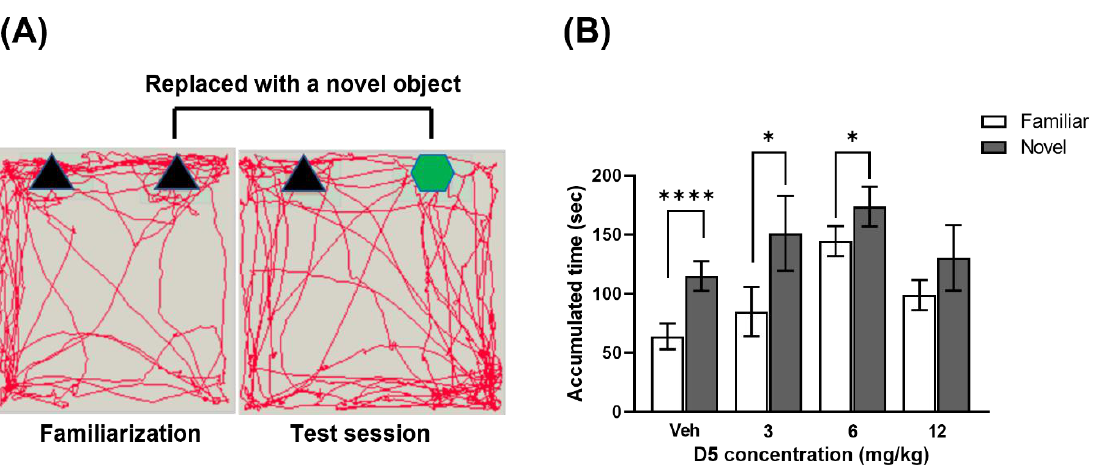
Figure 6. Effect of D5 exposure on memory ability in offspring mice. ( A ) Method of the novel object recognition test. ( B ) Bar graph of the accumulated time ratio of mice remaining in the area around the object. Significance was obtained using an ANOVA test. * p < 0.05 and p **** < 0.0001 vs. vehicle. Each value is expressed by the mean ± SEM.